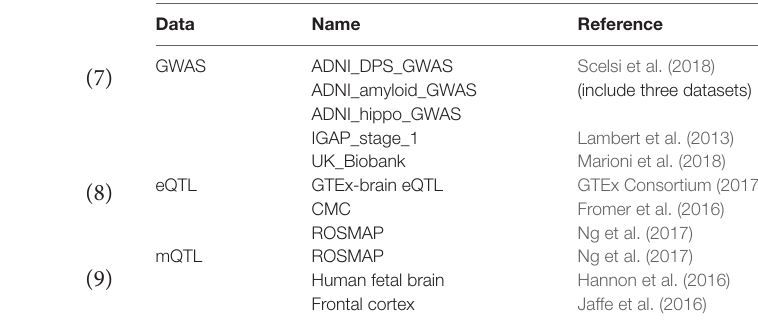
TABLE 1 | Datasets used in this